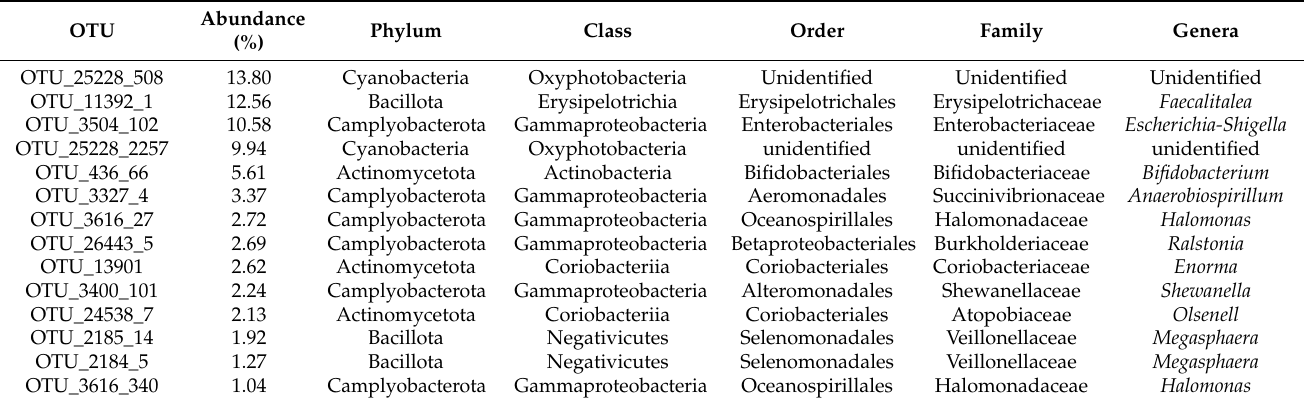
Figure 6. Non-metric multidimensional scaling analysis (NMDS) (PCA; ( A )) and the principal coor- dinate analysis (PCoA; ( B )) of the fecal microbiome composition. Each point represents the fecal microbiome of a black-billed capercaillie sample. 3.4. Prediction of Gut Microbiome Function Based on the functional prediction analysis, we predicted the 53 KEGG Level 2 cate- gories. All samples displayed high abundances in KEGG Level2 categories of the follow- ing protein families: genetic information processing (15.97%); protein families: signaling and cellular processes (5.58%), carbohydrate metabolism (8.75%), amino acid metabolism (6.64%); protein families: metabolism (6.57%), energy metabolism (4.55%), metabolism of cofactors and vitamins (4.11%), membrane transport (1.35%), and translation (2.87%) (Fig- ure S1).